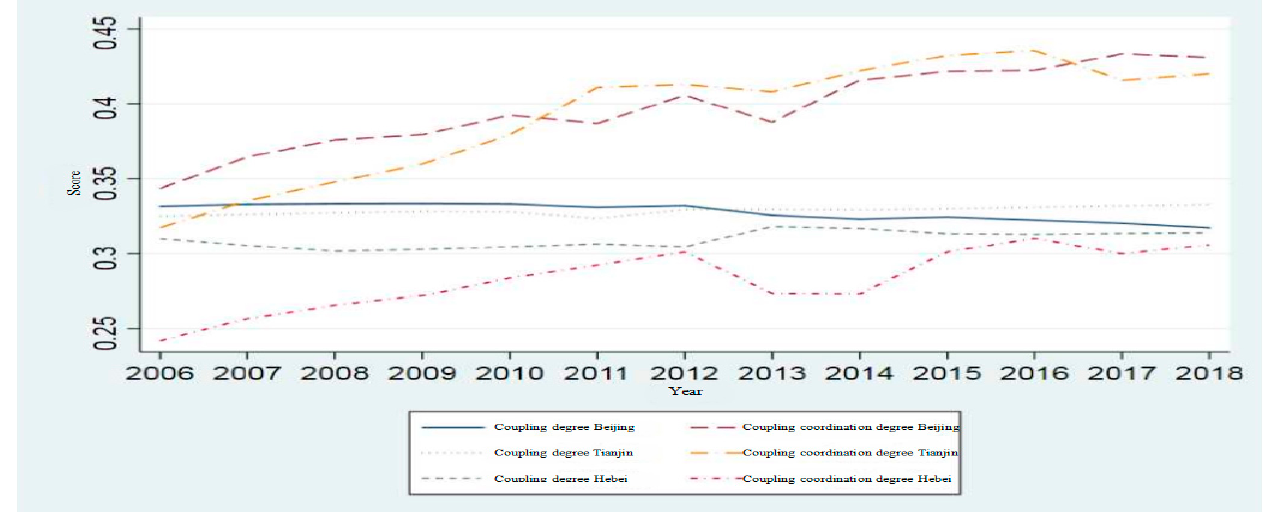
Figure 1. Coupling degree and coupling coordination degree of economy–ecology–high haze pol- lution industries, such as the thermal power industry, in the Beijing–Tianjin–Hebei region. The reasons for the discrepancies in the coupling degree and coordinated develop- ment degree of city clusters in the Beijing–Tianjin–Hebei region include three aspects (Fig- ure 2):